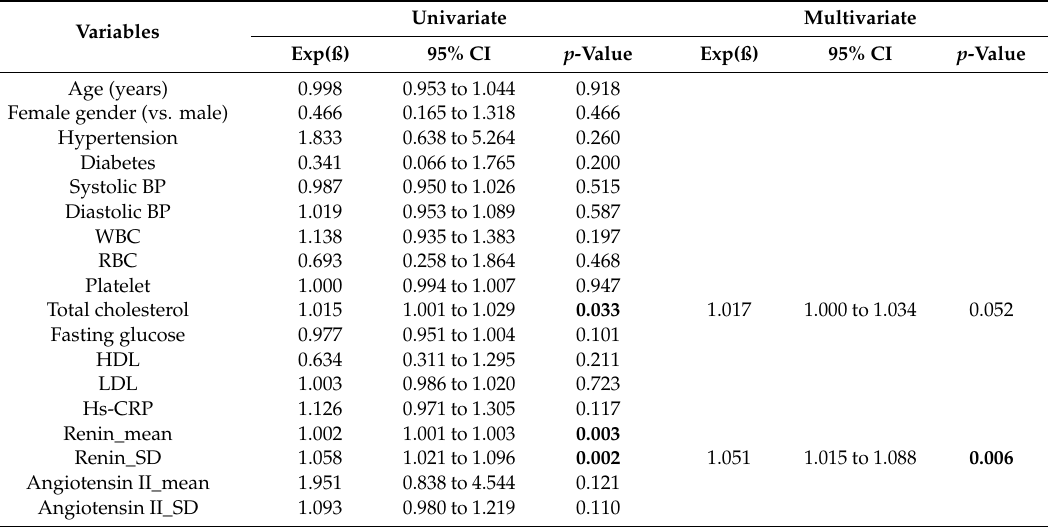
Table 4. Systemic factors associated with normal tension glaucoma